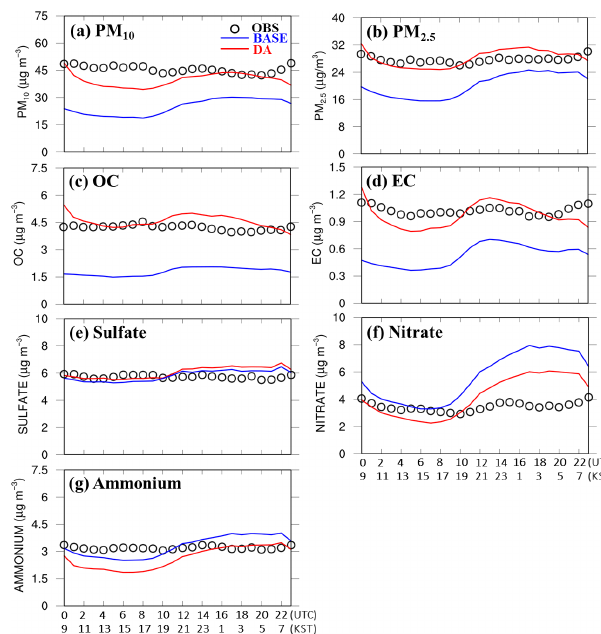
Figure 9. Aggregated average concentrations of (a) PM 10 , (b) PM 2 . 5 , (c) OC, (d) EC, (e) sulfate, (f) nitrate and (g) ammonium as predicted by CMAQ model during the period of the KORUS-AQ campaign. The others are the same as those shown in Fig. 7, except for the fact that the observation data used here were obtained from the seven supersite stations in South